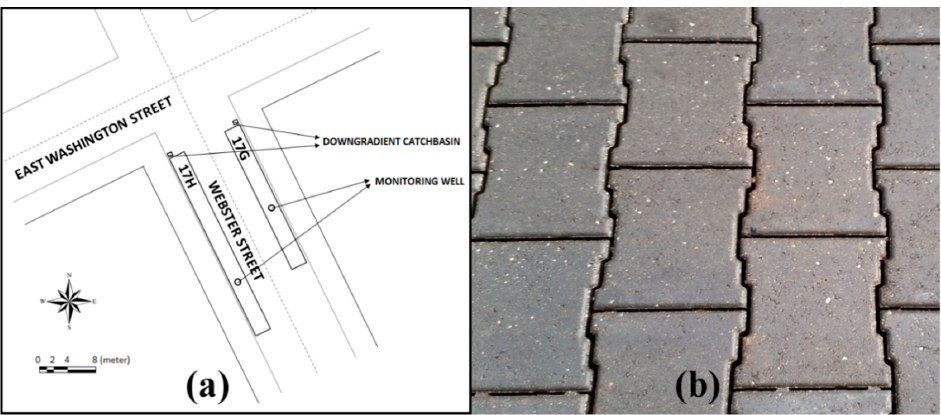
Figure 1. ( a ) Location of green infrastructures (GIs) 17G and 17H along parking lanes of Webster Street,